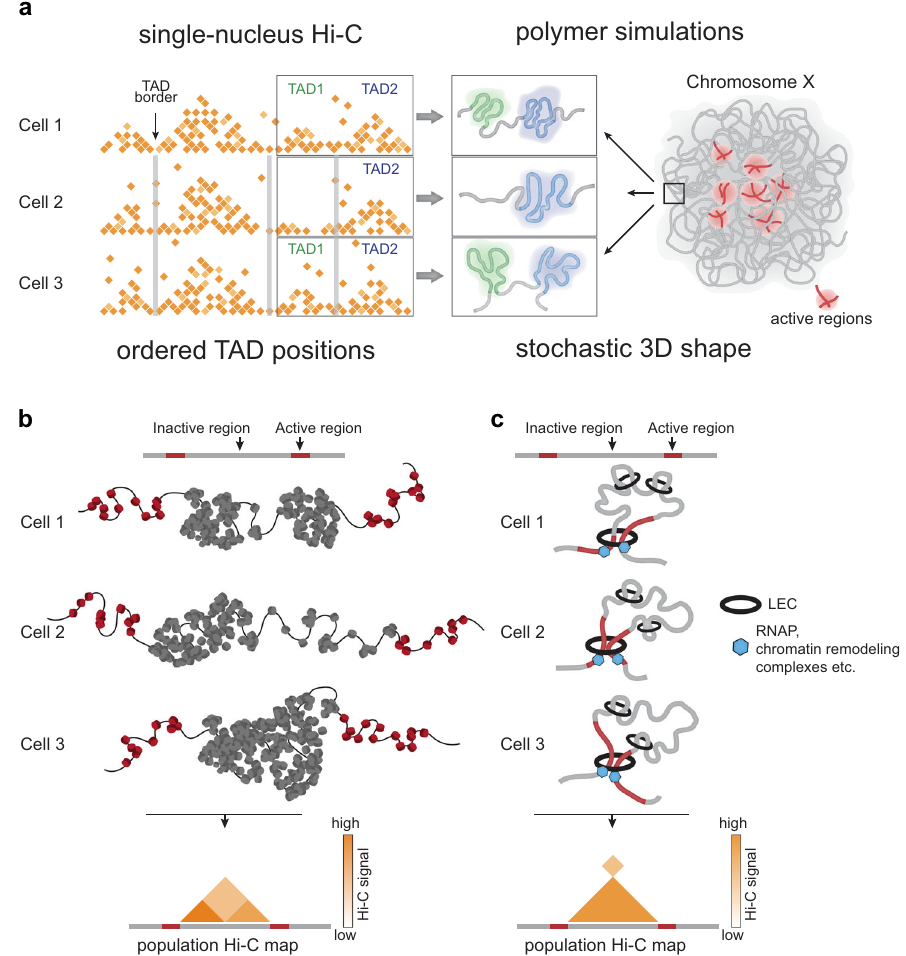
Fig. 6 Order and stochasticity in the Drosophila 3D genome. a Schematic representation of the ordered and stochastic components in the Drosophila genome folding. Positions of TAD boundaries are largely conservative between individual cells and determined by active chromatin. Chromatin fi ber path within a particular TAD and within the whole chromosome territory is largely stochastic and demonstrate prominent cell-to-cell variability. b Determined positions of active regions along the Drosophila genome de fi ne TAD boundaries persistent in individual cells. Inactive region is folded into chromatin globule due to interactions between non-acetylated “ sticky ” nucleosomes. This region adopts different con fi gurations in individual cells (and at different time points in a particular cell). In a cell 1, it is folded into two globules separated with stochastically formed fuzzy boundary. In a cell 2, one part of the region is compact (left) and the other part (right) is transiently decondensed. In a cell 3, the entire region forms one densely packed globule. Averaging of these con fi guration results in a TAD containing two sub-TADs in a population-based Hi-C map. Note, that the hierarchical structure of the TAD emerging in a population Hi-C map re fl ects different con fi guration of the region in individual cells. We note that the absence of any structure at inactive TAD borders denotes ambiguity of folding of these regions with snHi-C, but not the absence of this structure. c Extended active regions serving as barrier elements for potential loop extrusion complex (LEC) in Drosophila cells. It has been previously shown that transcription might interfere with loop extrusion 71,72 . Since stable TAD boundaries in Drosophila are enriched with transcribed genes, we propose that extended regions of active chromatin but not binding sites of architectural proteins represent barrier elements for LEC in Drosophila cells. In this scenario, LEC is looping out a TAD and terminates within fl anking active regions colliding with RNA-polymerases, large chromatin-remodeling complexes and other components of active chromatin. In different individual cells, termination occurs accidentally at different points within these regions. In a population-based Hi-C map that results in a compartment-like signal but not in a conventional pointed loop observed in mammalian cells where CTCF binding sites serve as barrier elements for